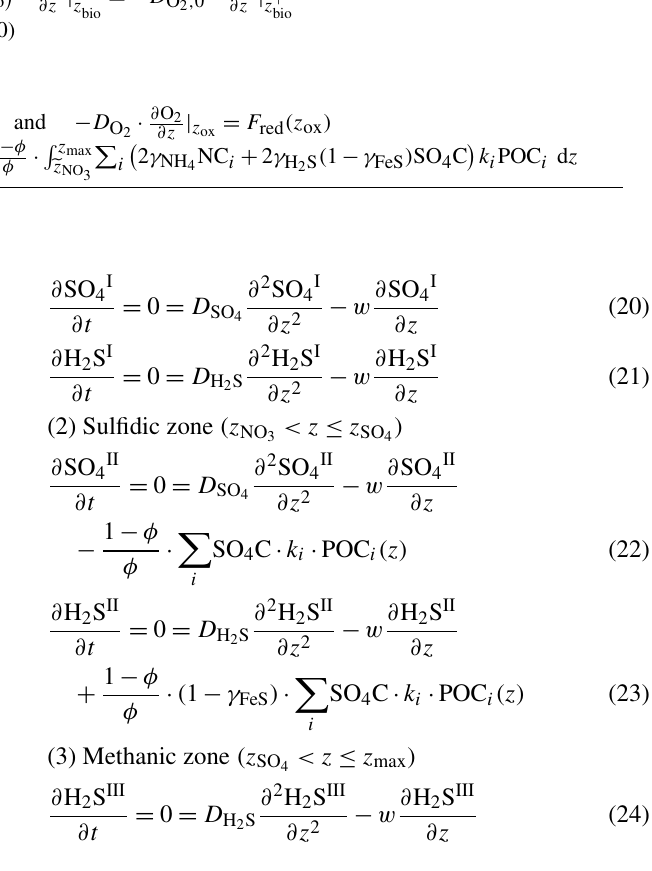
Table 3. Boundary conditions for oxygen. For the boundaries we define z − Boundary Condition z = 0 Known